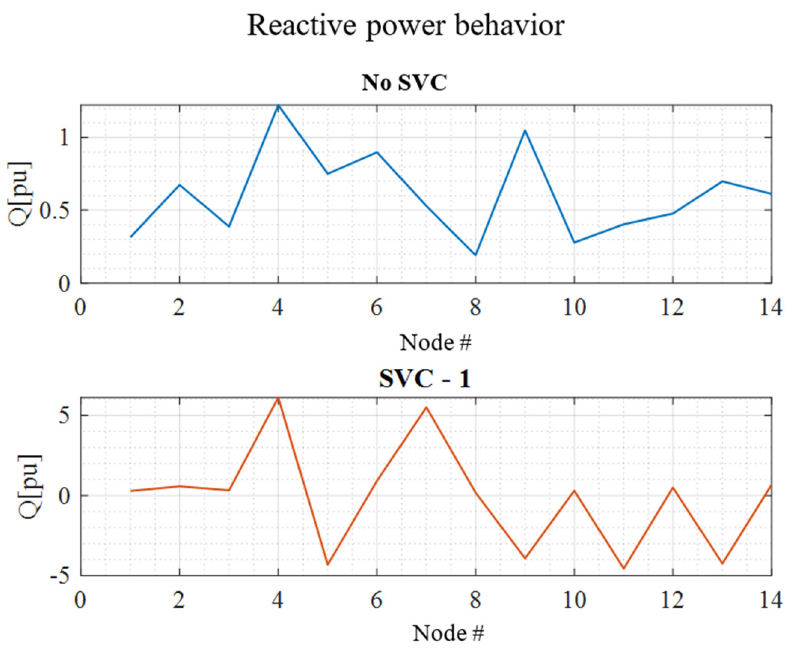
Figure 9. Profile of nodal reactive power in the IEEE 14-bus test system.